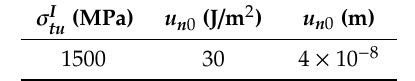
Table 4. SiC particle brittle cracking material model parameters.